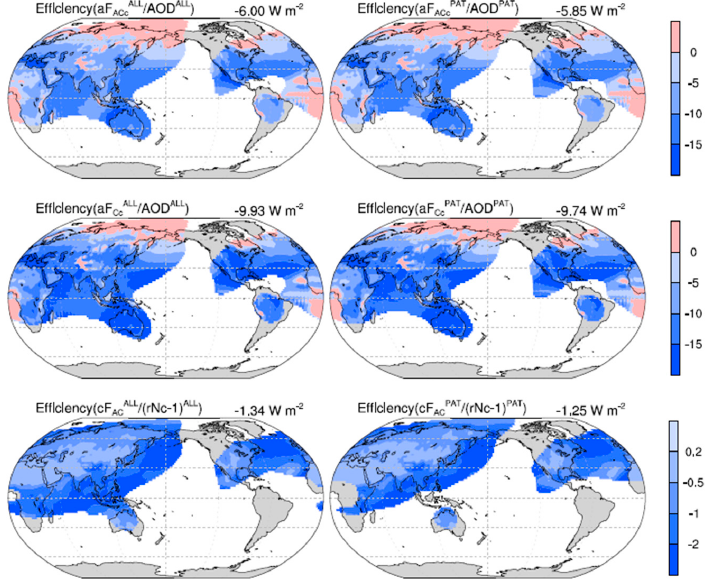
Figure 9. Annual means of the two radiative efficiencies for the anthropogenic aerosol direct radia- tive effect with and without the influence of natural aerosol (aF ACc /AOD and aF Cc /AOD, top two rows) and the efficiency for the Twomey effect (cF AC /(rNc − 1), bottom row) from the ALL (2000, left ) and PAT (1975, right ) experiments. The area with a low anthropogenic aerosol burden (AOD < 0.005 or rNc < 1.07) is